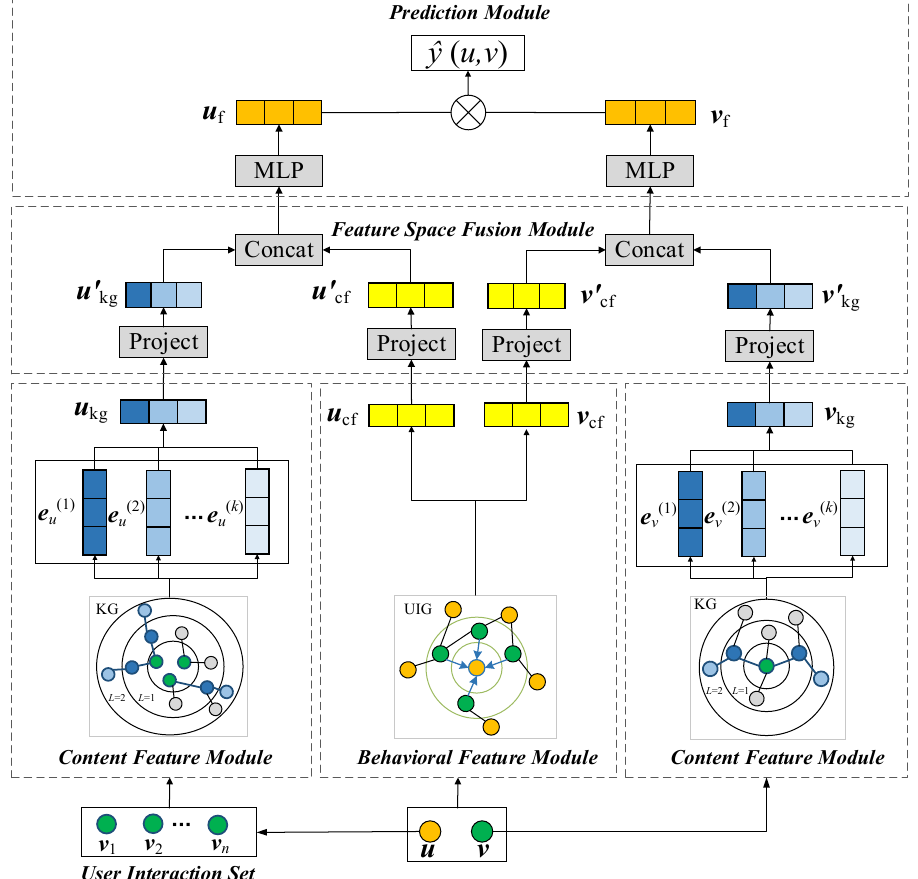
Figure 3. Illustration of the proposed KGRFSF model.